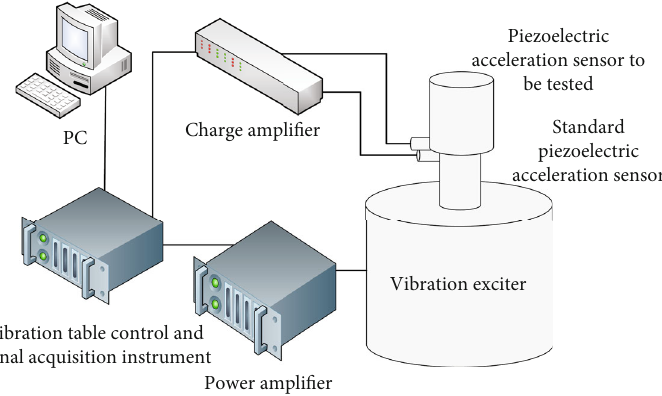
Figure 15: Schematic diagram of sensor calibration experiment test device.